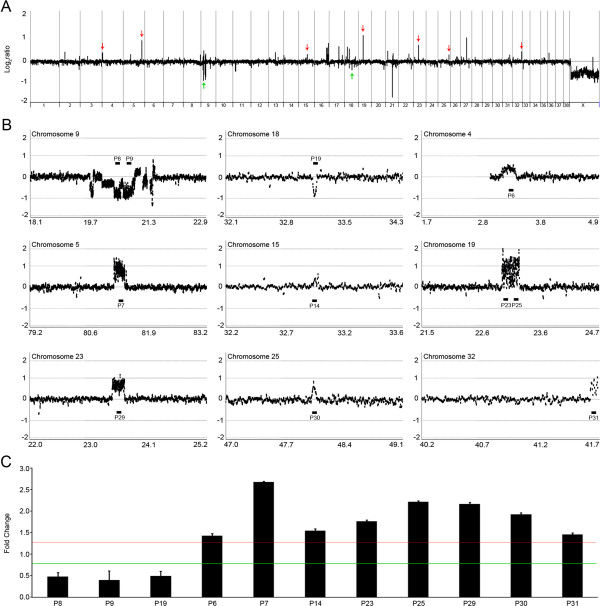
Whole-genome plot of CNVs and qPCR validation. (A) Whole-genome plot of CNVs identified between Labrador retriever and Boxer genomes. Nine CNV regions (7 CNV-Gs, red arrow; 2 CNV-Ls, green arrow) were randomly selected for qPCR validation. The X-axis represents individual chromosomes and the Y-axis represents signal intensity ratios (Labrador retriever/Boxer) on a log2 scale. (B) Log2ratio plot around the nine selected CNV regions. Black bars represent primer position for qPCR validation. The X-axis represents genomic position (Mb) and the Y-axis represents signal intensity ratios (Labrador retriever/Boxer) on log2 scale. (C) Three primer sets located in the CNV-L regions detected copy loss, and the other eight primer sets located in the CNV-G regions detected copy gain. The red and green line represent detection criterion for copy gain and copy loss, respectively. The Y-axis represents fold change based on the Boxer as the calibrator.